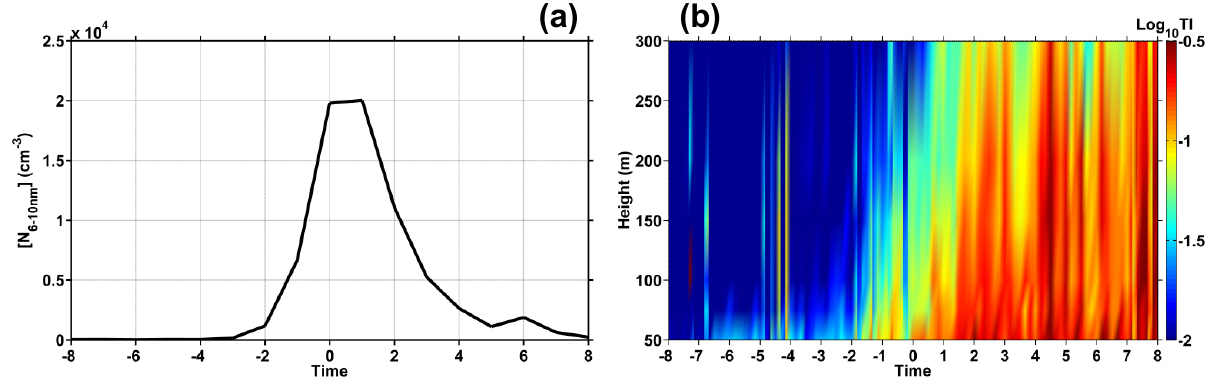
Fig. 4. (a) Mean 6–10nm particle number concentrations (cm − 3 ) and (b) Log 10 of turbulence intensity estimated from the 10 min average ZephIR lidar measurements during event class A days. The time coordinate is expressed relative to the hour the maximum rate change of 10nm particle concentrations was observed.